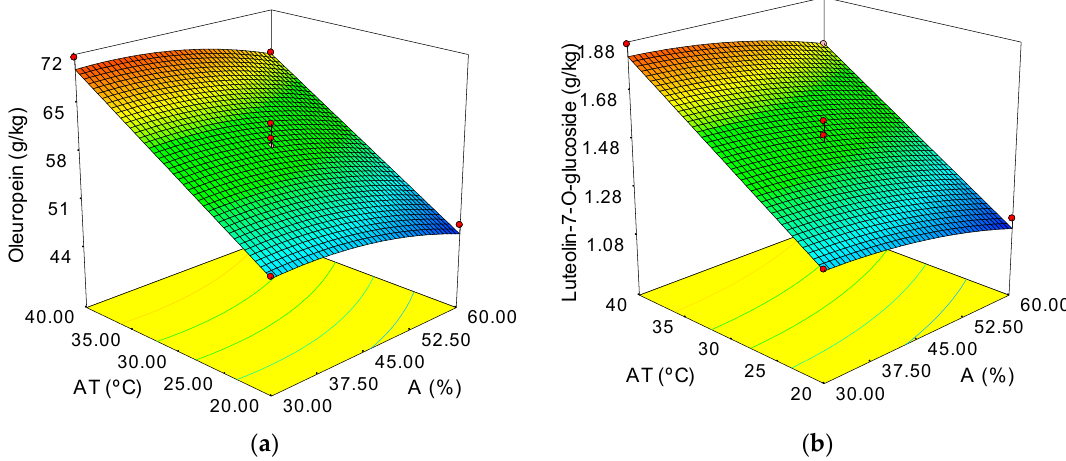
Figure 2. Response surface analysis for the oleuropein and luteolin-7-glucoside contents from olive leaves extracts with ultrasound-assisted extraction describing the influence of the factors increment of temperature and amplitude. The maxima of the responses are located at 60 °C and 30% amplitude. ( a ) Model graph for oleuropein content; ( b ) Model graph for luteolin-7-glucoside content. Table 4. Comparison of both extraction methods applied in this